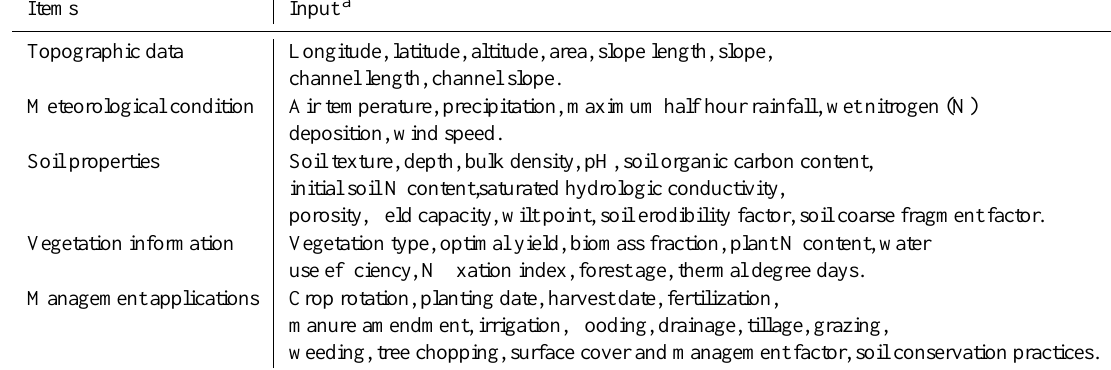
Table 1. Primary input variables.